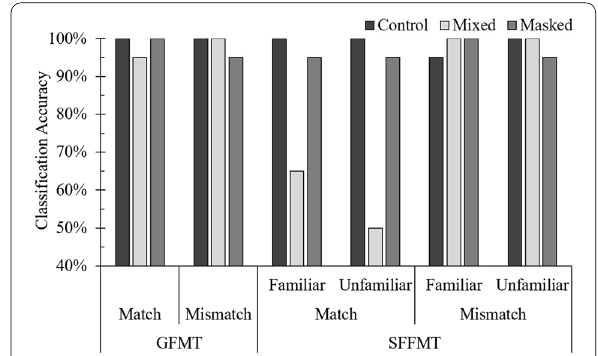
Fig. 3 Classification accuracy of the DNN, shown as the percentage correct of the 20 trials in each condition, plotted separately for the match and mismatch trials of the GFMT and the SFFMT